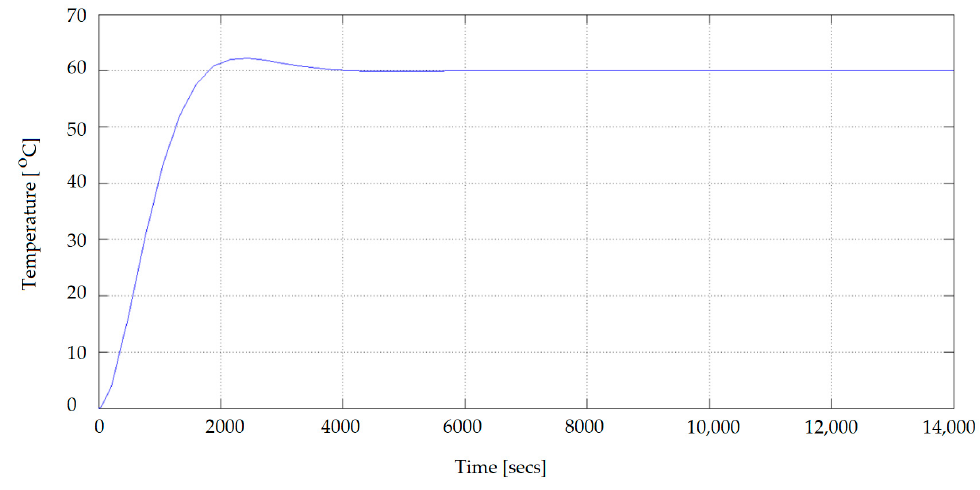
Figure 4. Temperature profile curve.